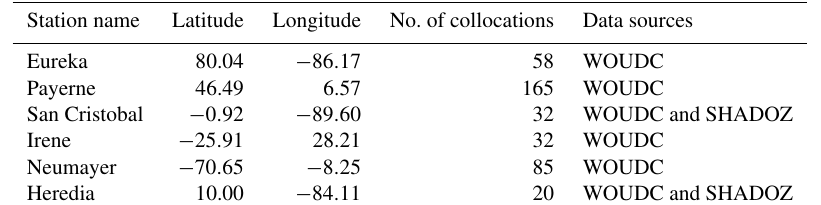
Table 2. Information about ozone sonde data used in comparisons.